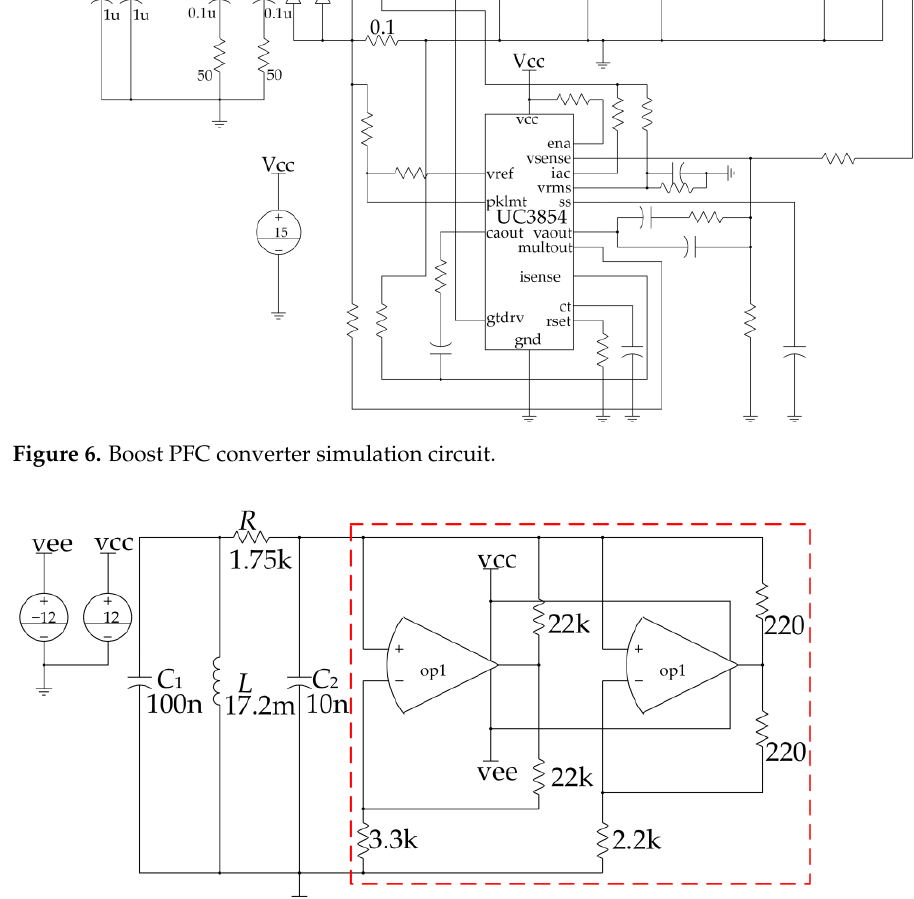
( b ) Figure 8. Drain – source voltage waveforms under regular and lossless snubbers: ( a ) Drain – source voltage waveform and ( b ) Drain – source voltage spectrum. The lossless snubber PFC converter with traditional PWM (TPWM) and chaotic spread spectrum was simulated. Chaotic signals were generated using Chua ’ s circuit with a spread spectrum of ±10 kHz. Furthermore, the spectrum of v ds under TPWM and chaotic spread is shown in Figure 9. The simulation results show that the v ds spectrum of CSS – LS has good continuity. The energy of the v ds spectrum at the switching frequency and its multiples was dispersed to the surrounding frequencies by using CSS – LS. The energy dispersion reduces the peak value of the v ds spectrum with CSS – LS. Compared to the v ds spectrum with TPWM+LS, the peak of the v ds spectrum with CSS – LS decreases significantly. At 300 kHz~10 MHz, the v ds spectrum with CSS – LS is reduced by 6~20 dBµV compared to the v ds spectrum of TPWM + LS. The simulation results verify the ac- curacy of the theoretical analysis, and the chaotic spread spectrum can optimize the EMI suppression effect of the lossless snubber.